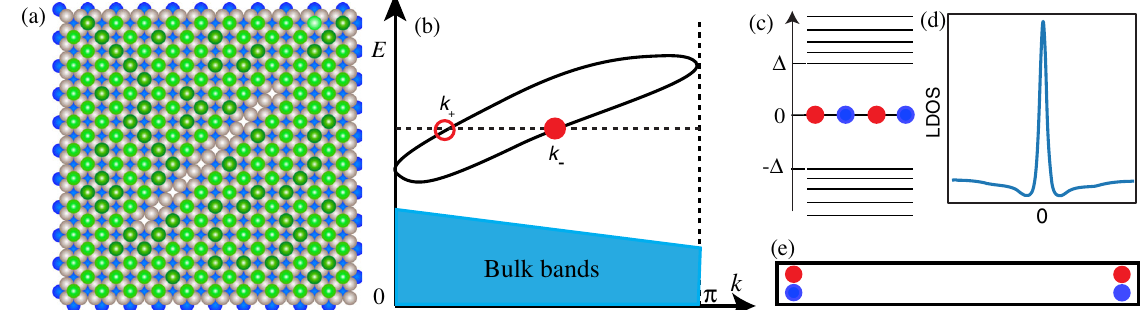
FIG. 1. (a) Schematics of monolayer Fe(Te,Se) with an atomic line defect of missing Te/Se atoms along the (1,1) direction. Blue and green balls are Te/Se atoms below and above, respectively, the plane of Fe atoms (silver balls). Random distributed light green balls represent the Se atoms, while the dark green balls represent the Te atoms. (b) Schematics of Rashba-split impurity bands. The open and solid red circles mark the Fermi points. (c) Energy spectrum of the TRI TSC in a RALD with open boundaries, showing four MZMs (blue and red dots) inside the SC gap. (d) Local density of states (LDOS) spectrum at both ends shows a zero-energy conductance peak. (e) Blue and red pairs of MZMs form a Kramers doublet, localized at both ends of the